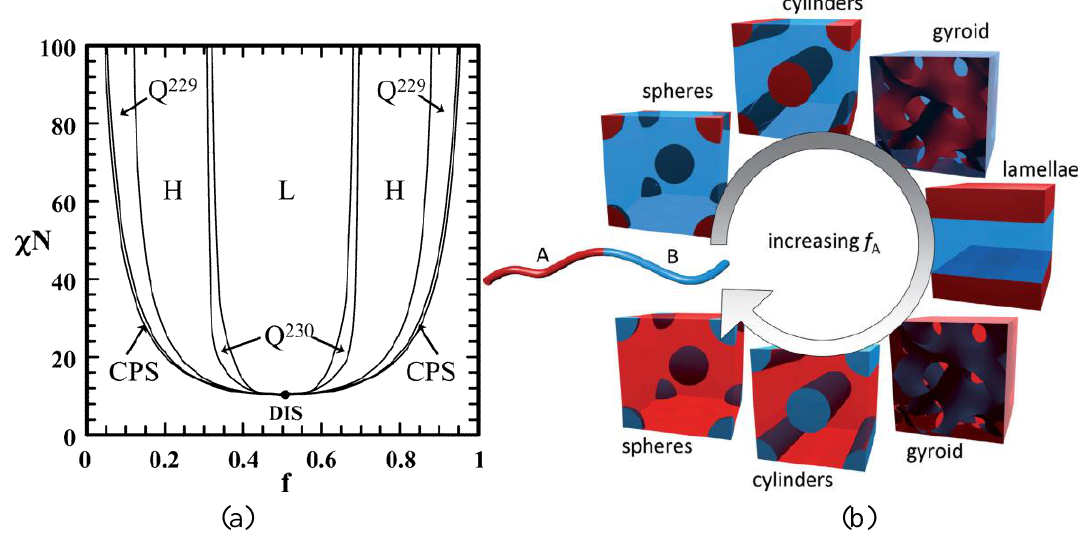
Figure 1. (a) Typical phase diagram of a coil-coil diblock copolymer. f : Volume